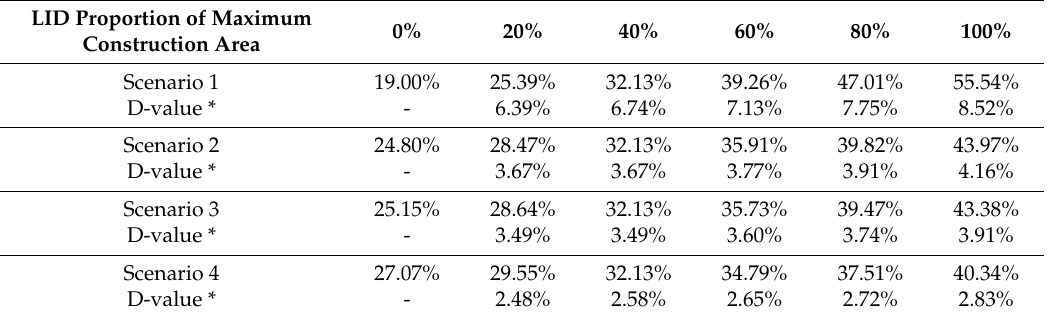
Table 8. Reduction rates of peak flow in various LID